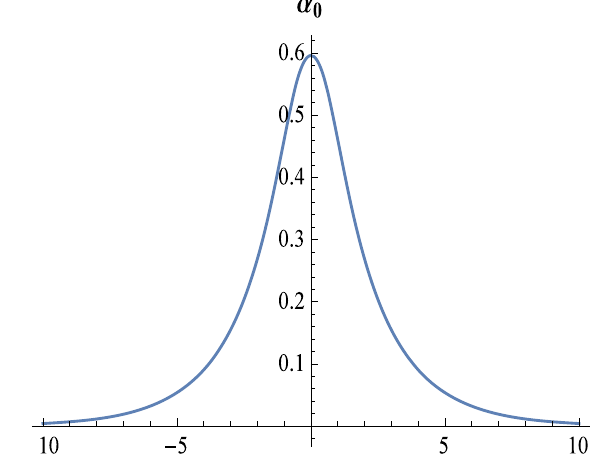
Fig. 3 The shape of the Elko zero mode Eq. (69) in the thick brane models. The parameters are set to a = k = 1 a finite function of z . So we have α 0 ( z ) ∝ exp